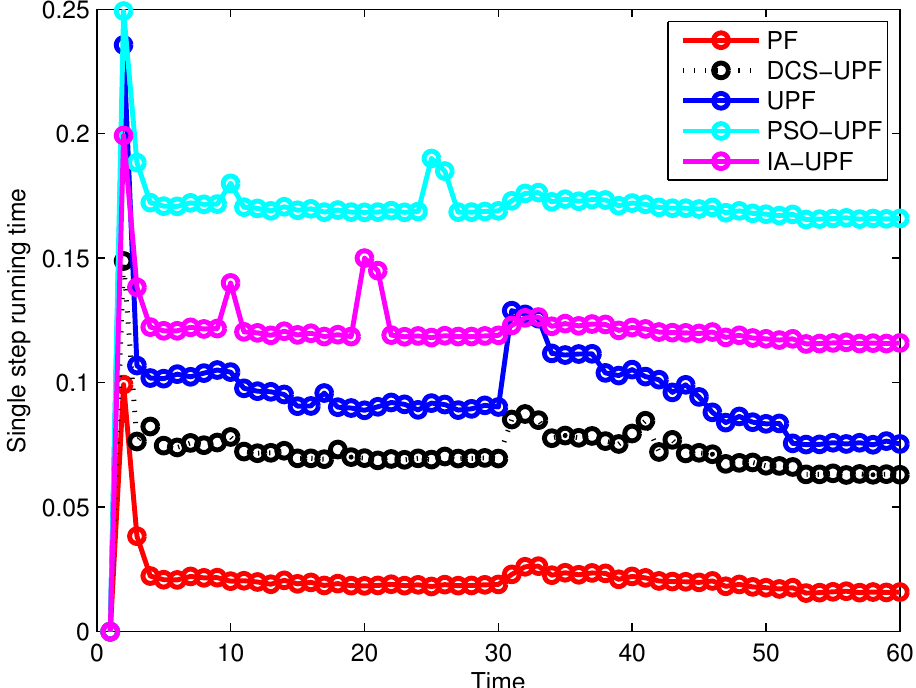
Figure 15. The one-step running time of PF, UPF, PSO-UPF, IA-UPF and